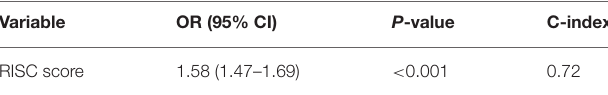
TABLE 4 | Validation set: extubation within 72h predicted by